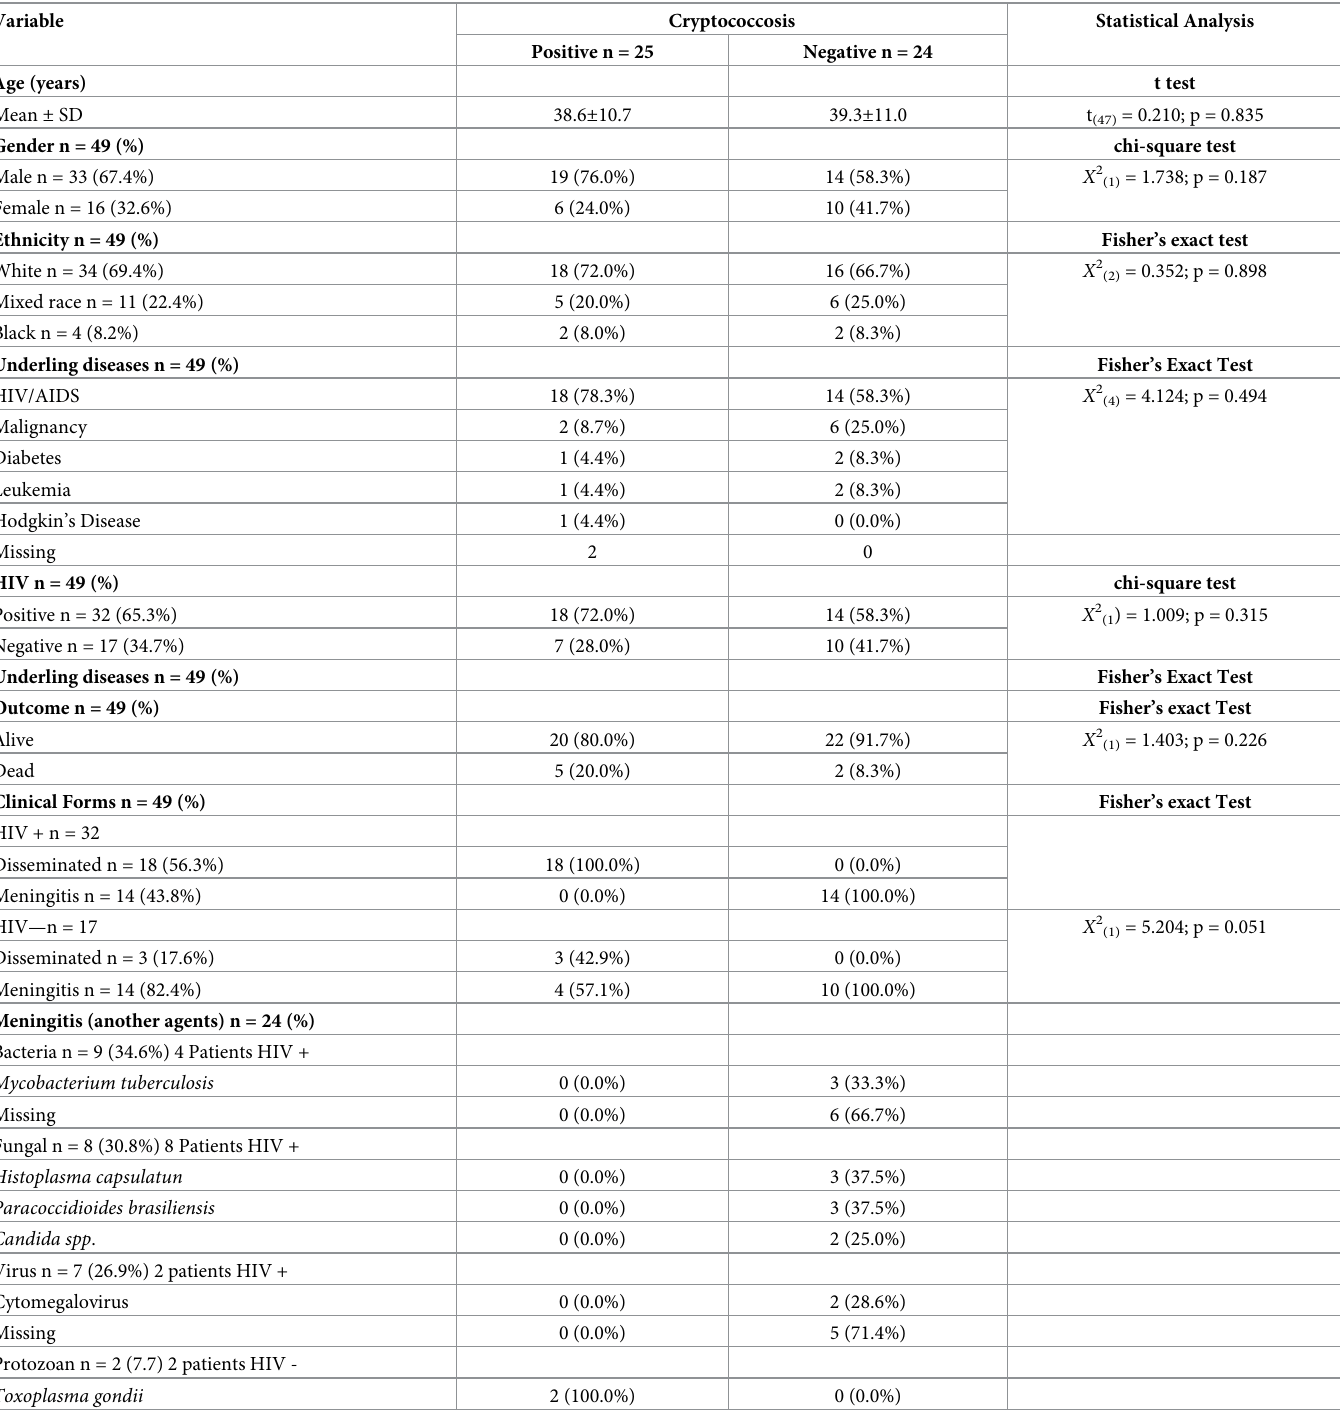
Table 3. Demographic and clinical data of study